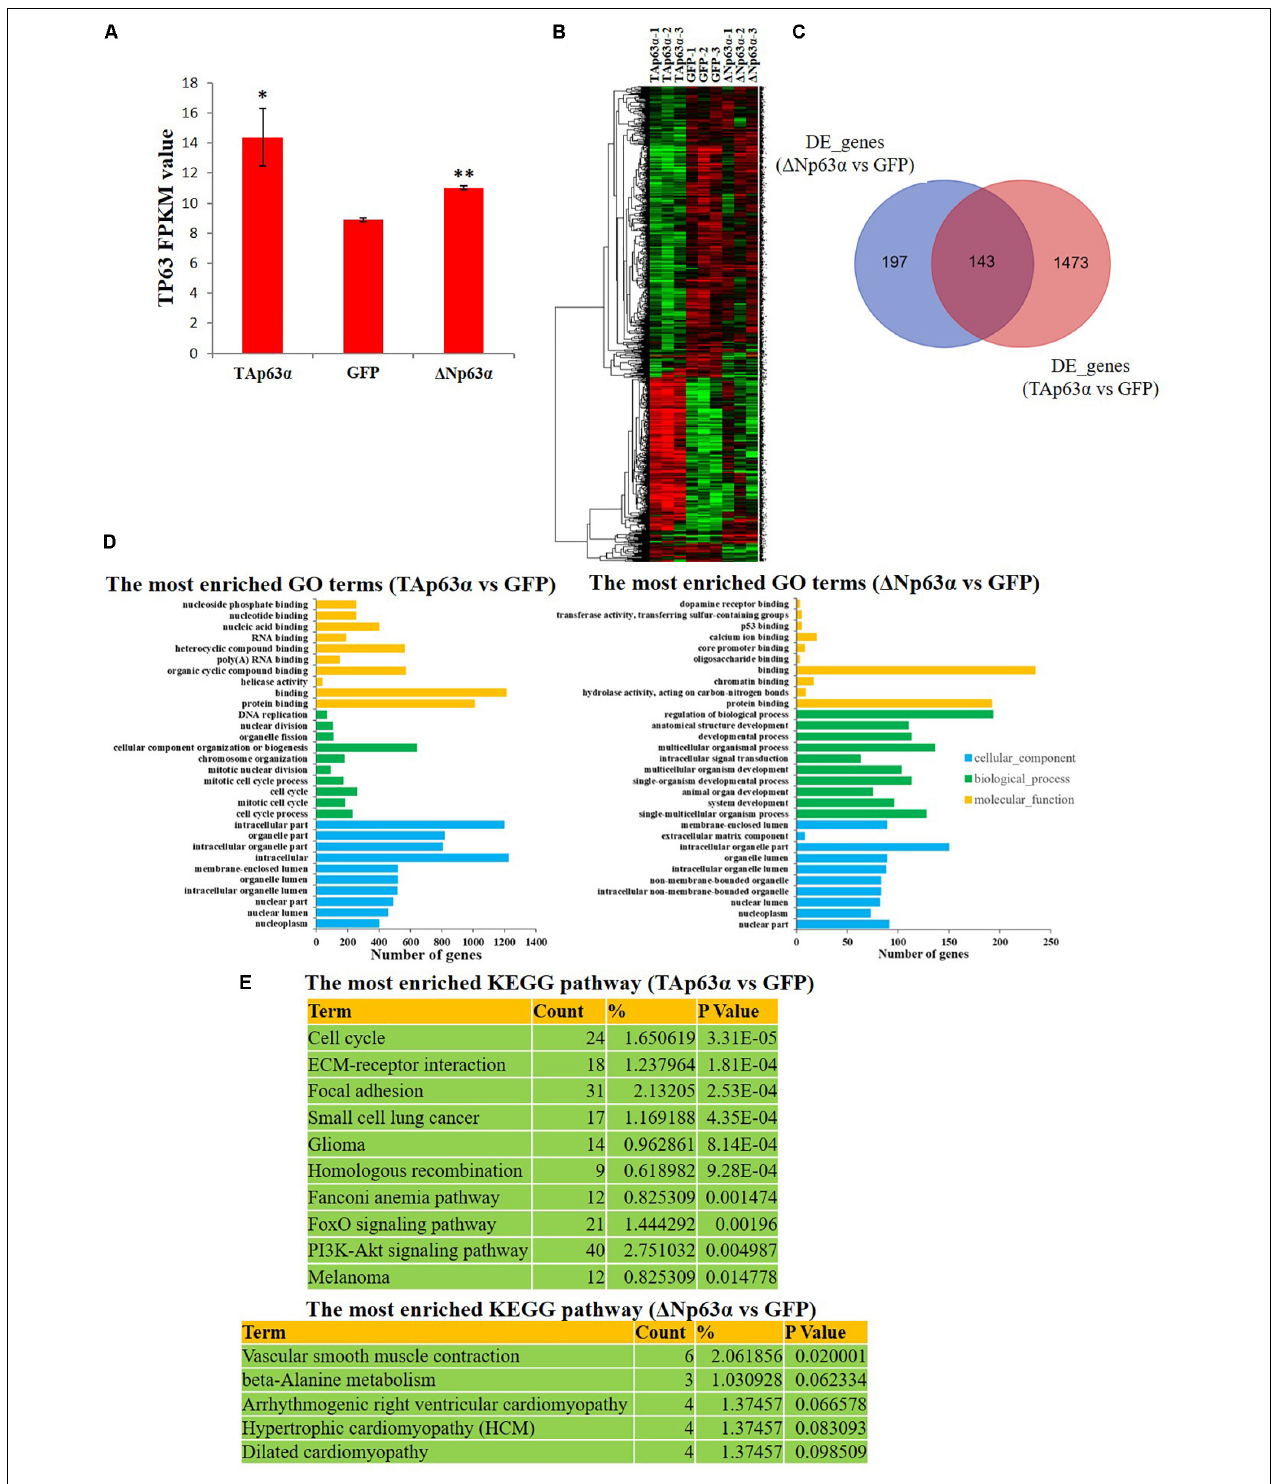
FIGURE 4 | TAp63 α and (cid:49) Np63 α regulate different sets of genes in myoblasts. (A) RNA-seq result showed the success of TAp63 α and (cid:49) Np63 α overexpression in chicken primary myoblast. (B) Hierarchical clustering of differential expressed genes (DEGs) between TAp63 α (TP), (cid:49) Np63 α (NP) and GFP (NC) overexpression groups. (C) The Venn diagram of DEGs between “ (cid:49) Np63 α vs. NC” and “TAp63 α vs. NC.” (D) GO enrichment for the DEGs between “TAp63 α vs. NC” and “ (cid:49) Np63 α vs. NC.” The y -axis represents GO terms and the x -axis represents number of genes (with p -value < 0.05). (E) The most enriched KEGG pathway for the DEGs between “TAp63 α vs. NC” and “ (cid:49) Np63 α vs. NC.”